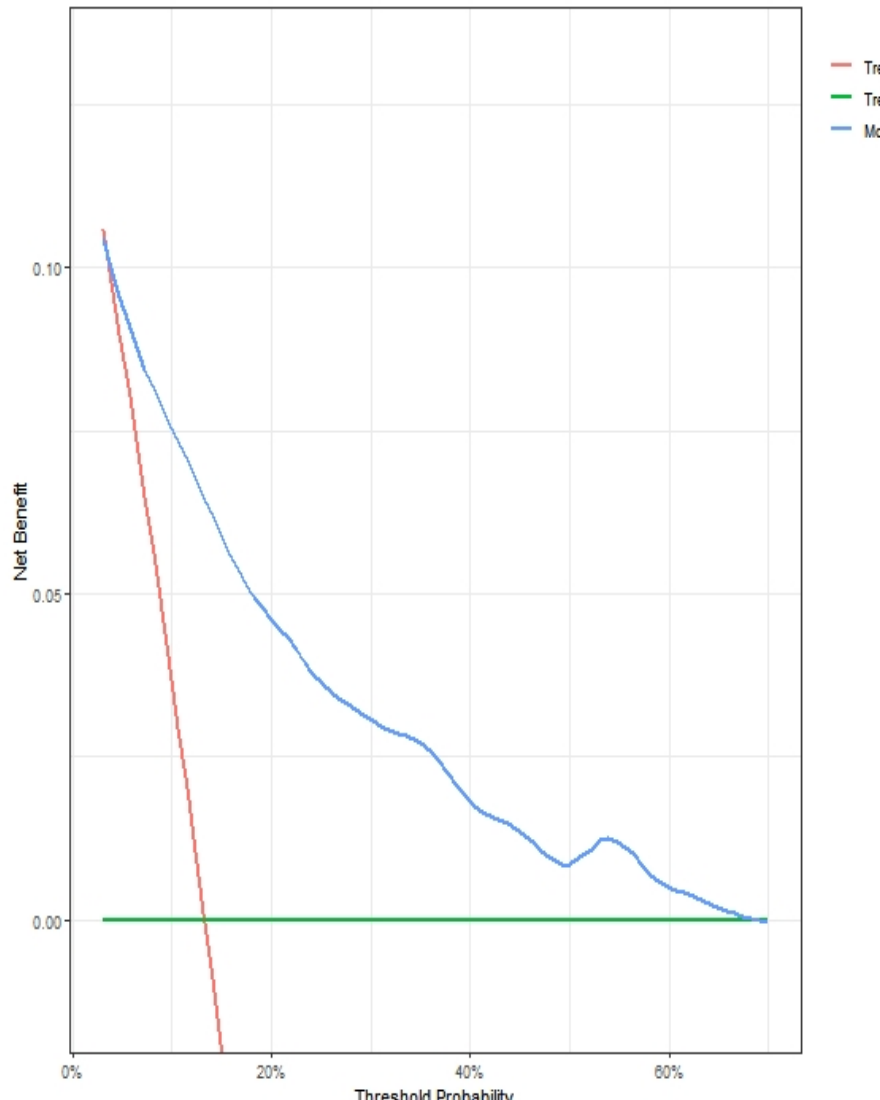
Figure 3. Two decision curve analyses delineating the clinical net benefit after using the potential model for the objective standard regarding when to perform preoperative chest computed tomography in 890 patients with renal cell carcinoma who underwent nephrectomy at a single institution, 2011–2020.